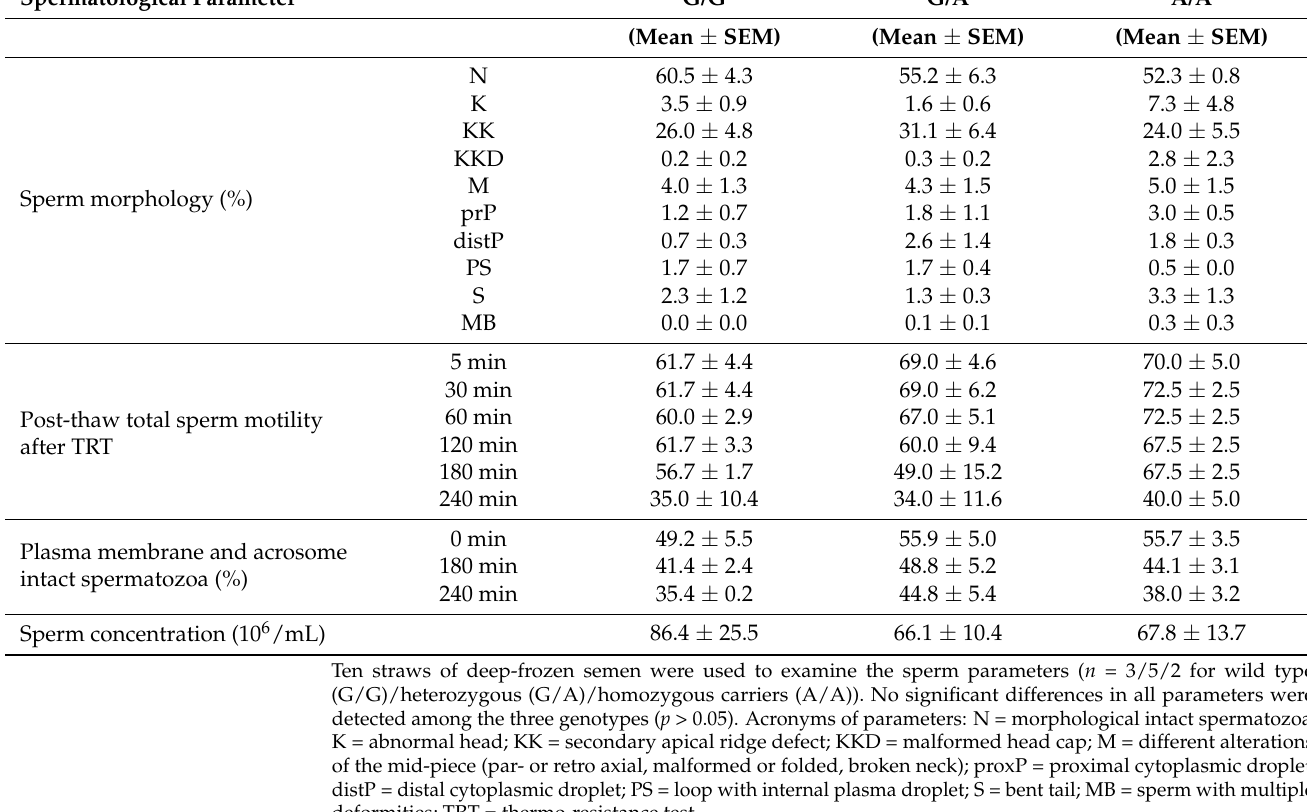
Table 1. Spermatological parameters analysis of deep-frozen semen in bulls of three